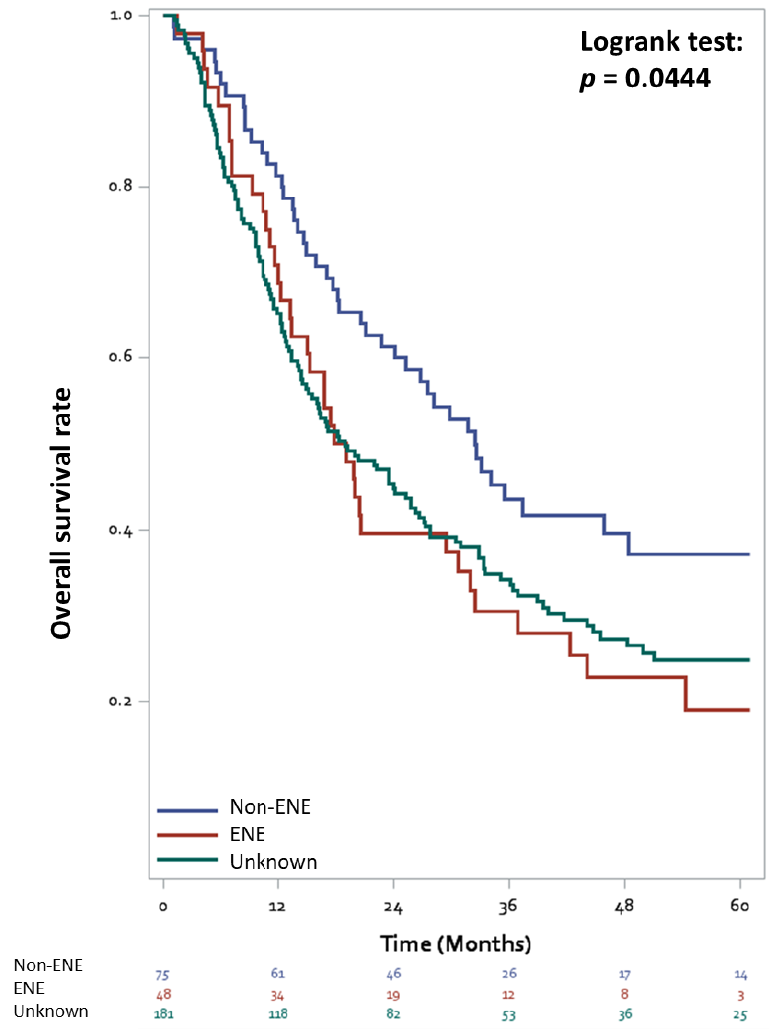
Figure 1. Overall survival curves stratified by the status of extranodal extension in bladder cancer patients with lymph node involvement treated with radical cystectomy.